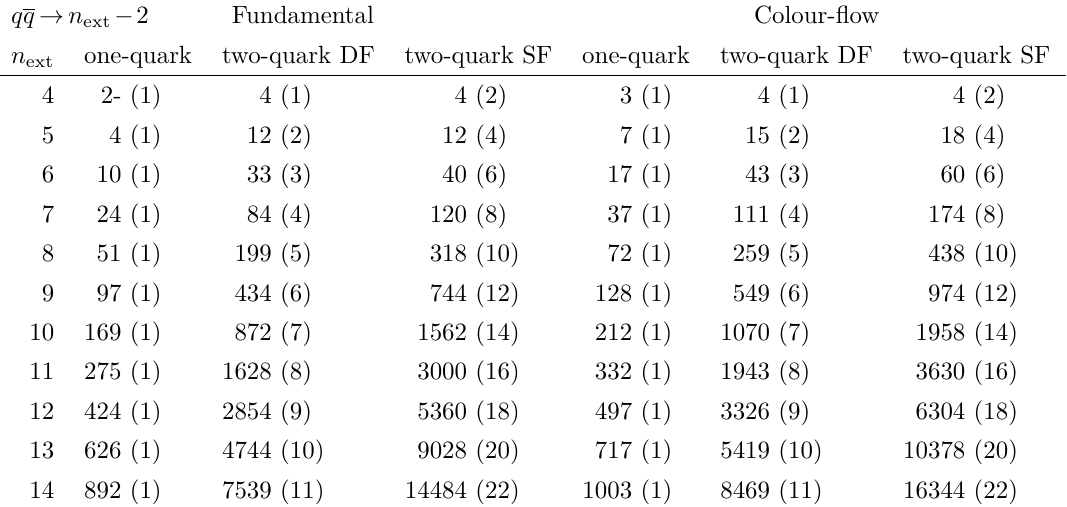
Table 9 . Number of non-zero elements in the colour matrix at NLC and at LC (in parenthesis) including the reduction due to the phase-space symmetrisation, for qq initial state for one-quark-pair and two-quark-pair (same-flavour (SF) and distinct-flavour (DF)) processes for various numbers of final-state particles ( n 2 ) in the fundamental and colour-flow ext −